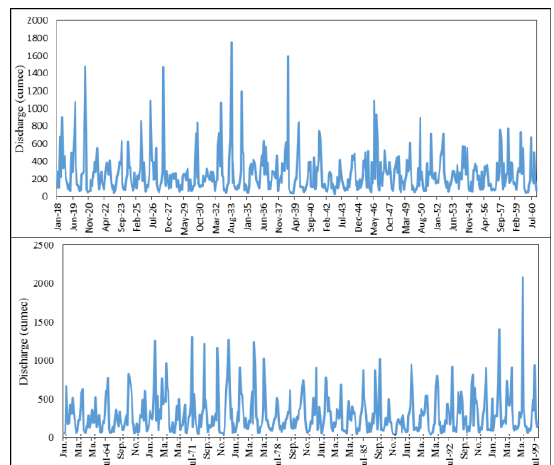
Figure 17: Beas basin hydrographs for future